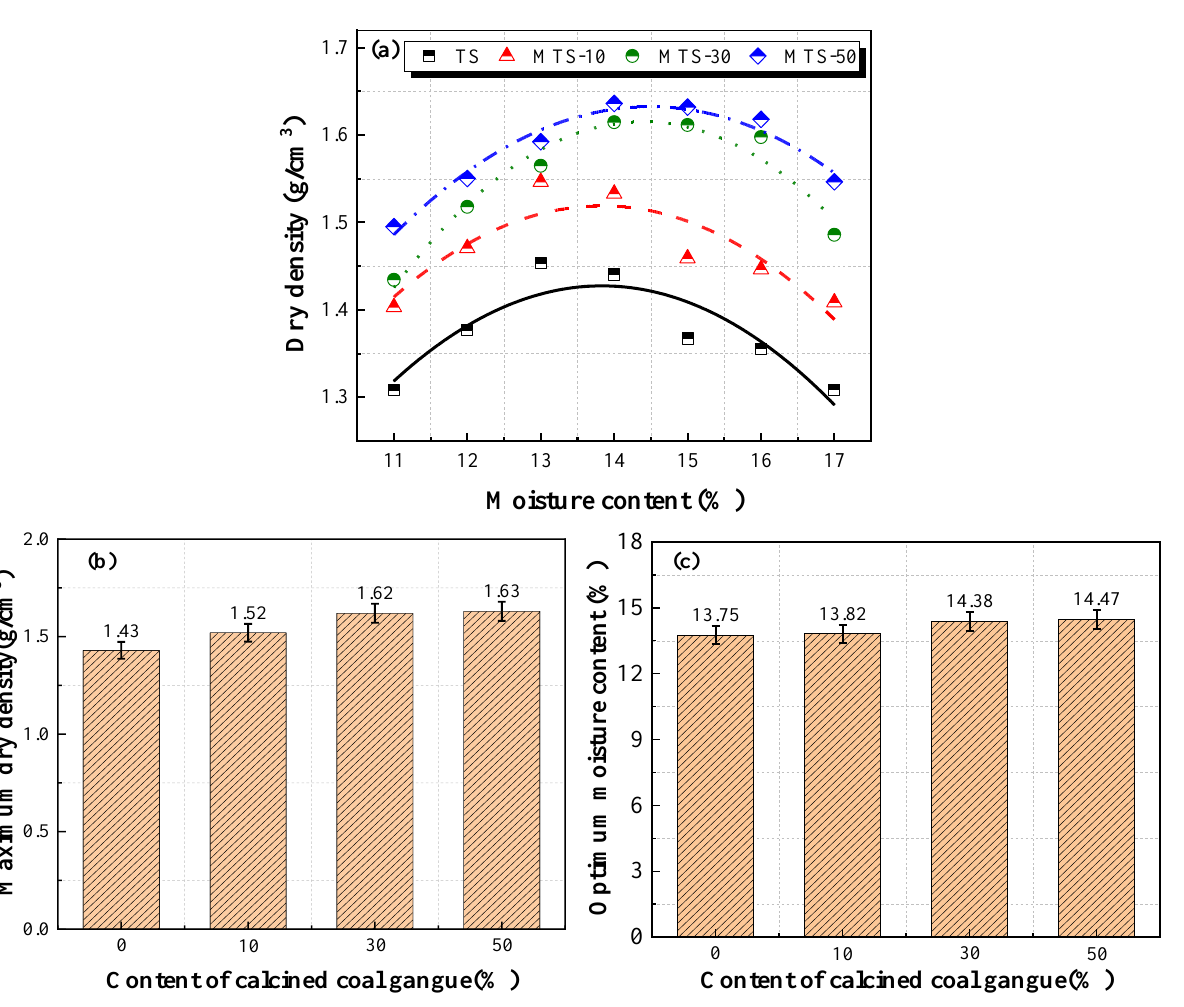
Figure 10. ( a ) Relationship of dry density and moisture content, maximum dry density ( b ), and optimum moisture content ( c ) at different CACG contents.